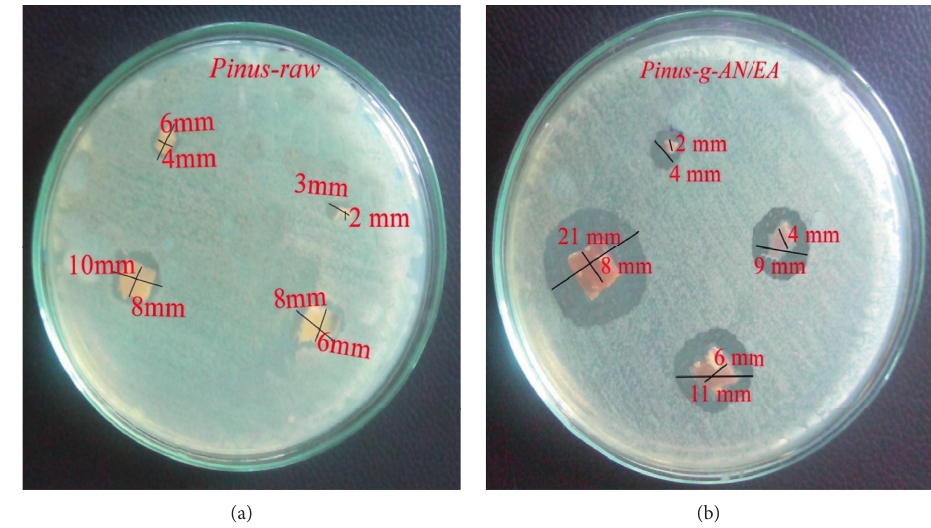
Figure 7: Antibacterial activity images of (a) pinus-raw and (b)